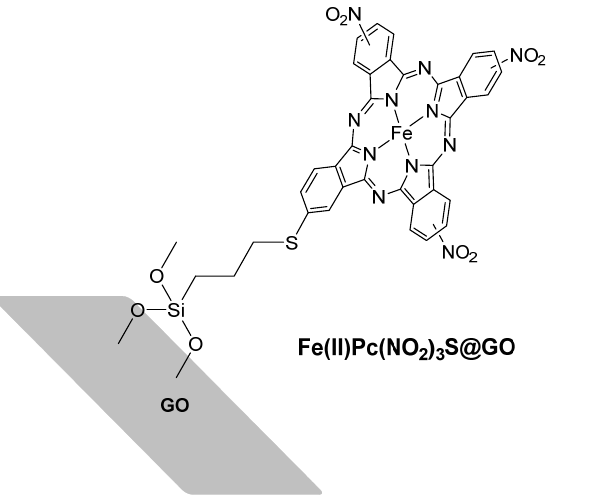
Figure 25. Schematic representation of the hybrid catalyst Fe(II)Pc(NO 2 ) 3 S@GO obtained from the iron phthalocyanine FePc(NO 2 ) 4 and graphene oxide (GO) nanosheets (adapted from [74]). Chauhan and Yan [75] reported the preparation and evaluation of an efficient cata- lyst, a copper tetrasulfonate phthalocyanine (tetrasodium salt) Cu(II)Pc(SO 3 Na) 4 immobi- lized through electrostatic interaction on a quaternary amine functionalized nanocrystal- line cellulose ( NCCel ) (Figure 26).